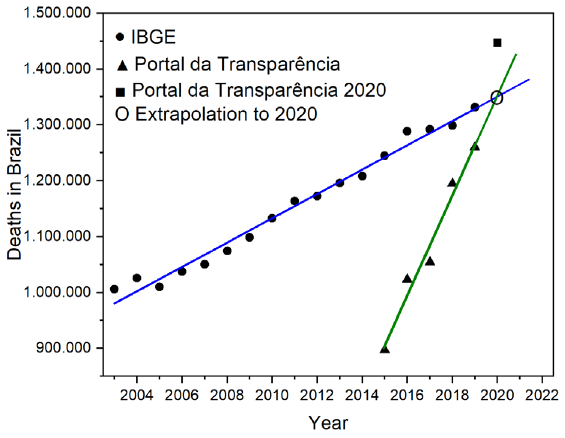
Figure 1. Total number of deaths in Brazil between 2003 and 2019. The black circles correspond to data from IBGE (SIDRA 2019) since the beginning of the series in 2003. The blue line is the linear adjustment and these data. The black triangles represent the data of the Transparency Portal available (PORTAL 2021). The green line is the linear adjustment to this data. The point of intersection between the lines corresponds approximately to the extrapolation of both for the year 2020. The black square is the number of deaths in the Transparency Portal for the year 2020. Note that the two sets of data have years in common, but in which the data do not coincide. The Transparency Portal is a more recent base and we believe that it will gradually be completed, so that in the future the slope will be similar to the slope of the linear adjust from IBGE data. Interestingly, in the graph we observe that as of 2020, without a pandemic, the two series would coincide. It is normal that large databases only guarantee their data after a certain time has elapsed. Clear examples of this are the databases of earthquakes and magnetic storms, among